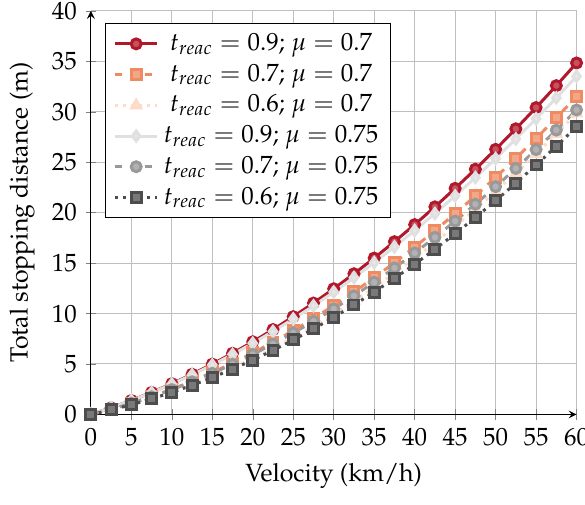
Figure 6. Braking distances.